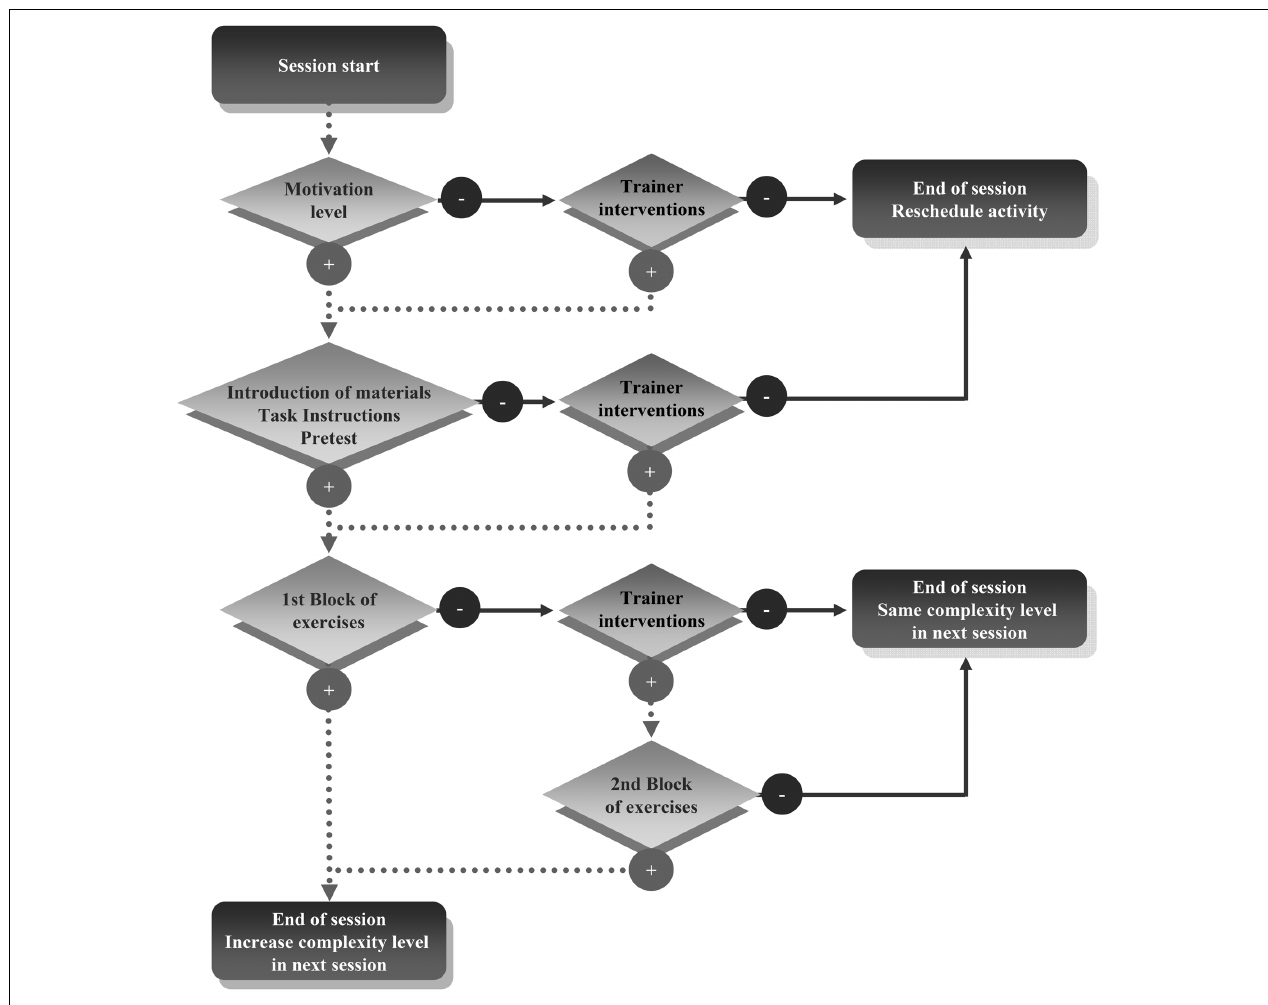
FIGURE 2 | Flowchart of the structure of each training